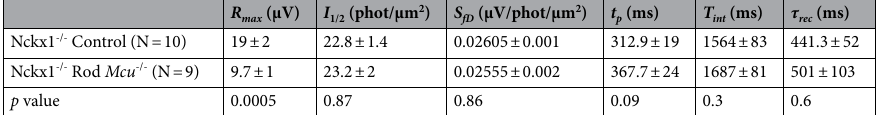
Table 3. Dim flash response sensitivity and kinetics parameters. R max saturated response amplitude measured at the plateau, I 1/2 intensity required to produce half of the saturated response, S fD dark adapted sensitivity, t p time to peak of a dim flash response, t int integration time of the response, τ rec recovery time constant during response shut